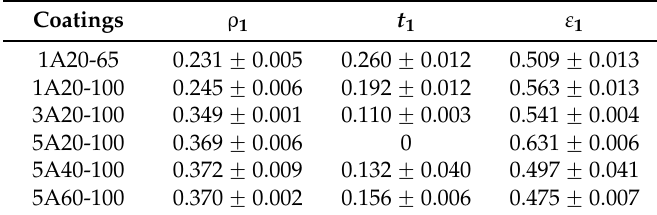
Table 3. Emissivity, reflectivity and transmissivity coefficients of coatings.